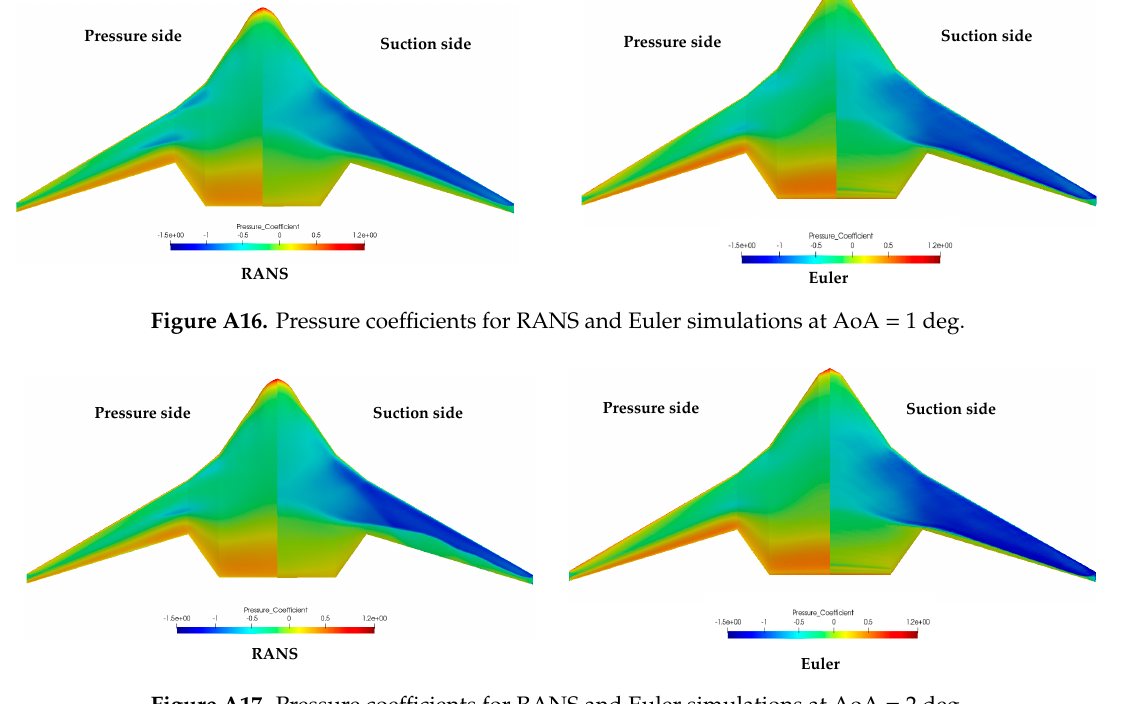
Figure A15. Pressure coefficients for RANS and Euler simulations at AoA = 0 deg.